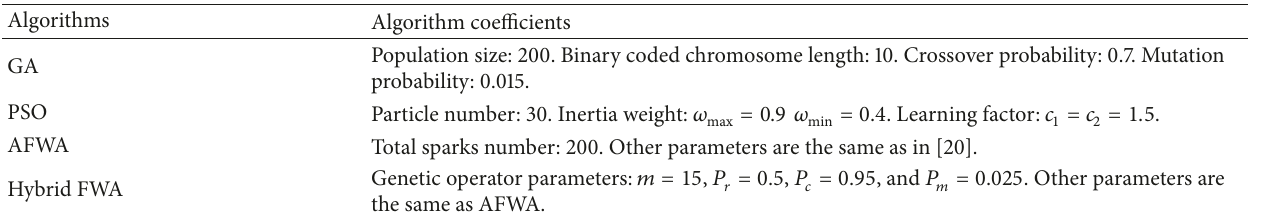
Table 2: Parameters settings in